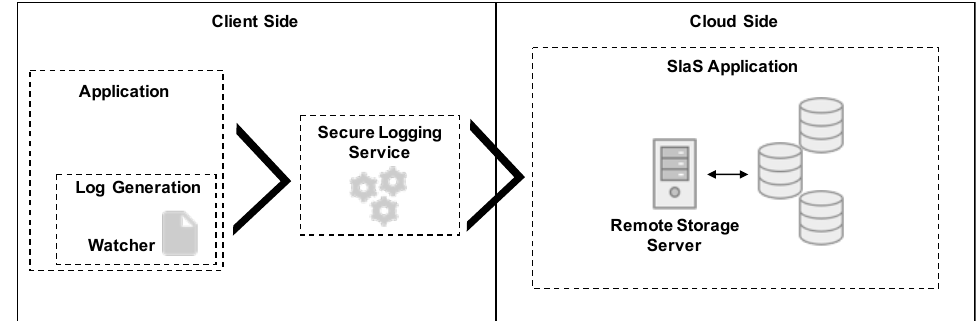
Figure 2. Flow of data within the